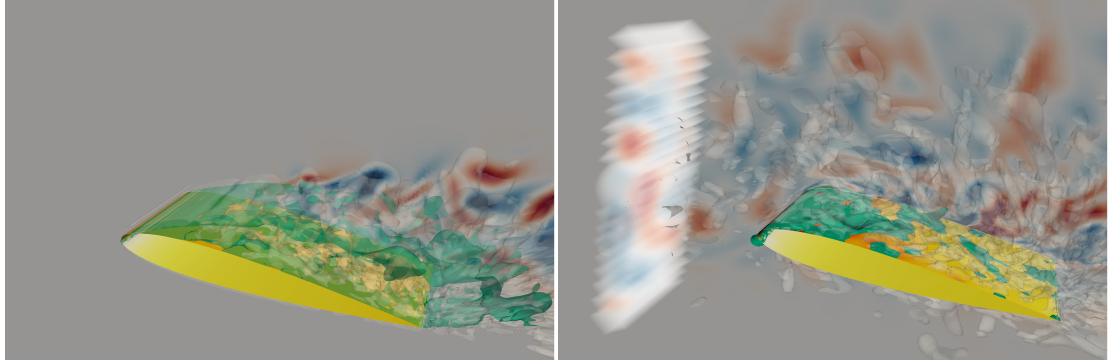
Figure 10. Instantaneous view of the NACA0012 airfoil flow in laminar ( left ) and turbulent ( right ) freestream. Reverse flow in separation is marked by green iso-surfaces. Fluctuations are indicated by red/blue color and by gray iso-surfaces of Q-criterion. The forcing zone is located upstream of the airfoil.